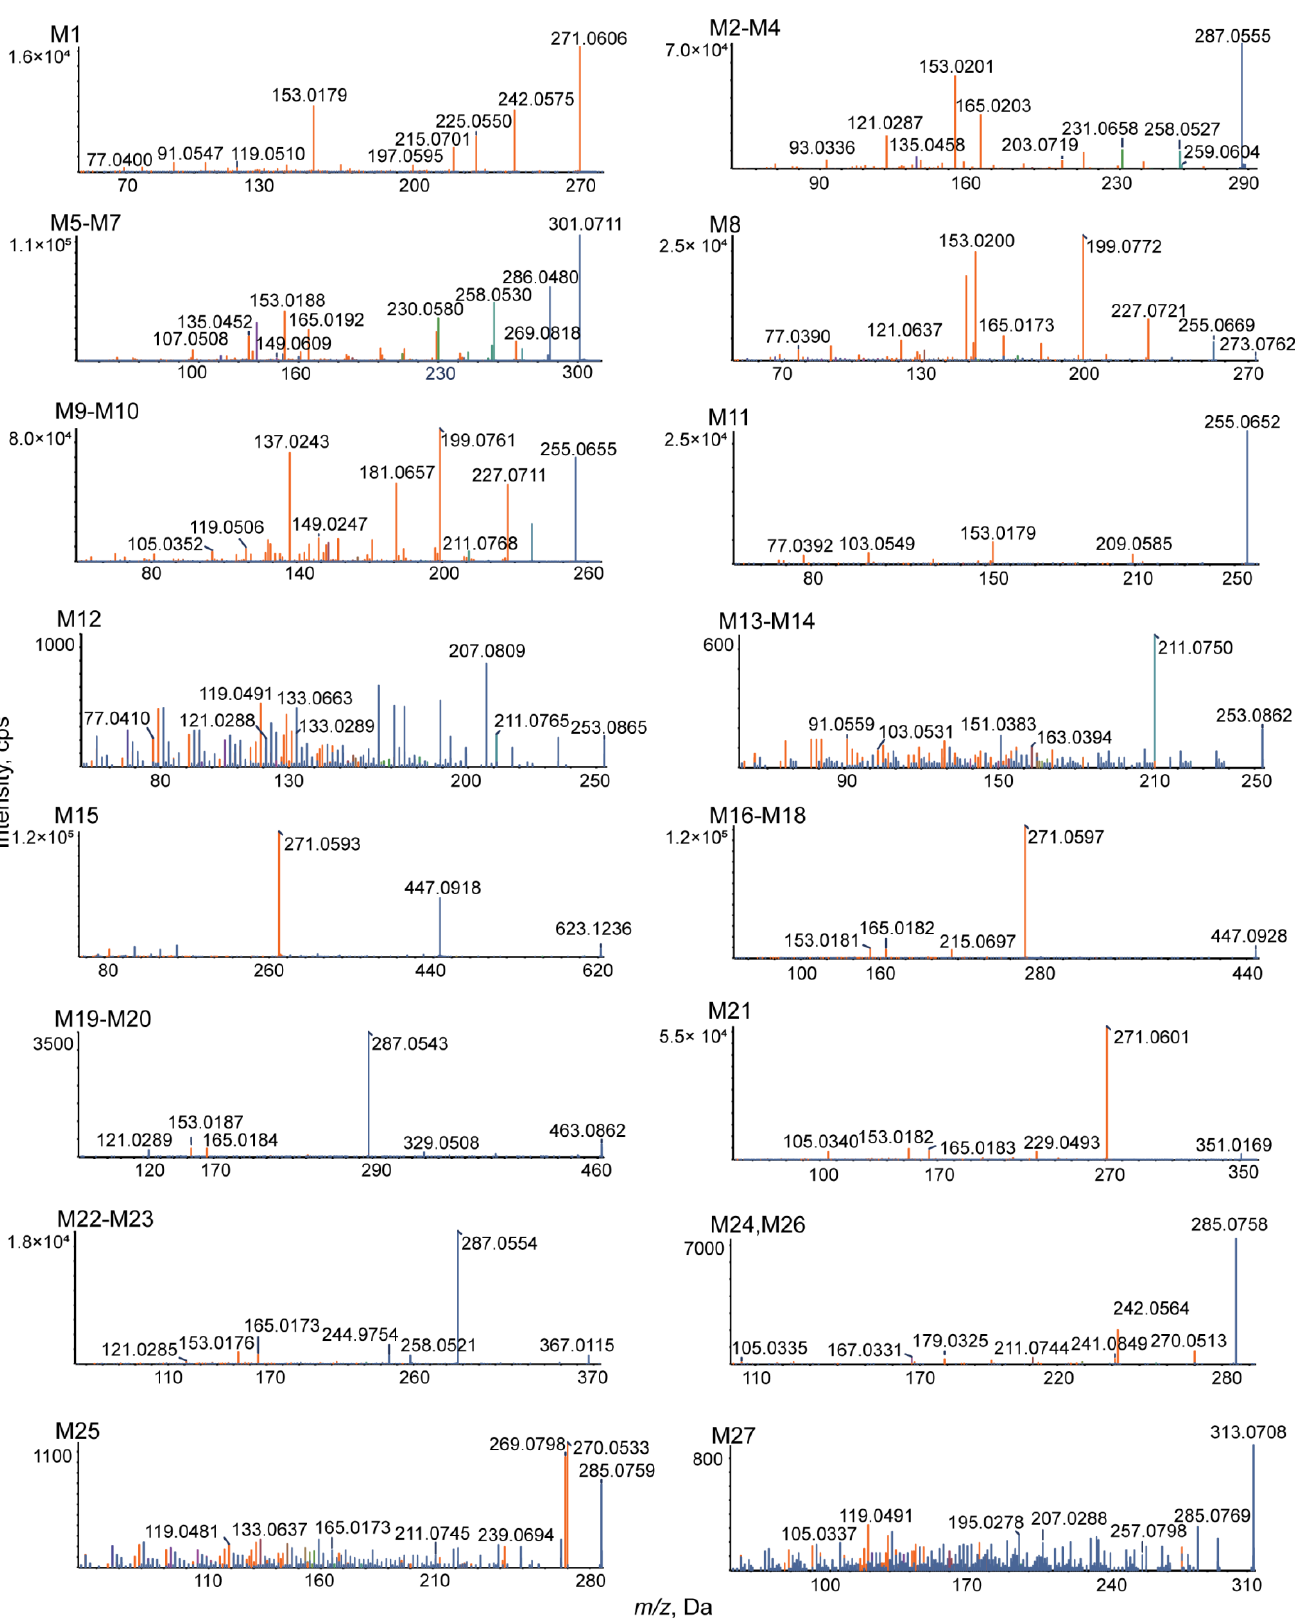
Figure 7. MS/MS spectra of all metabolites of galangin in vitro and in vivo.